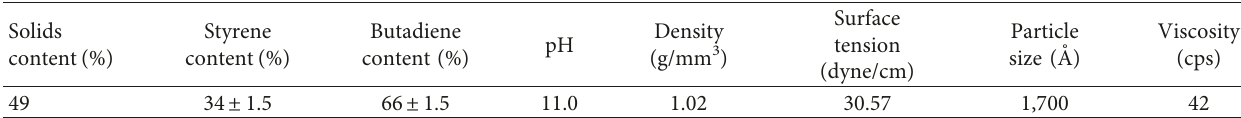
Table 5 is reproduced from the Kim and Park [35]